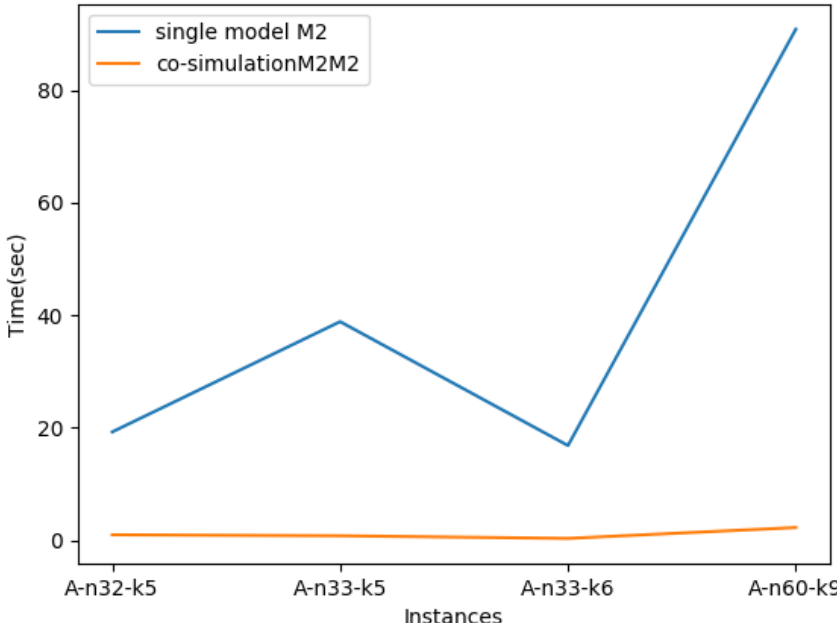
Figure 6. The execution time of co-simulation models compared with single model M 1 or M 2 .